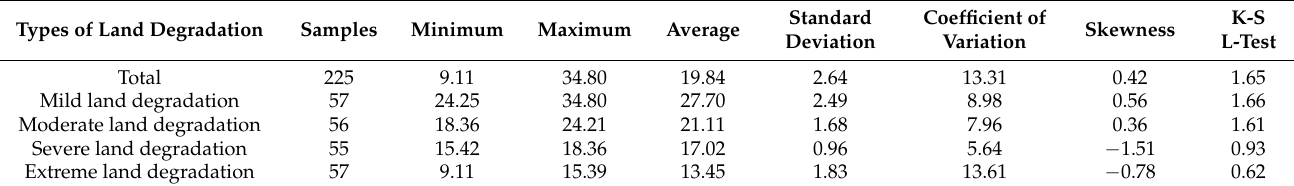
Table 2. Descriptive statistic characteristics of SOM in soil with different land types.